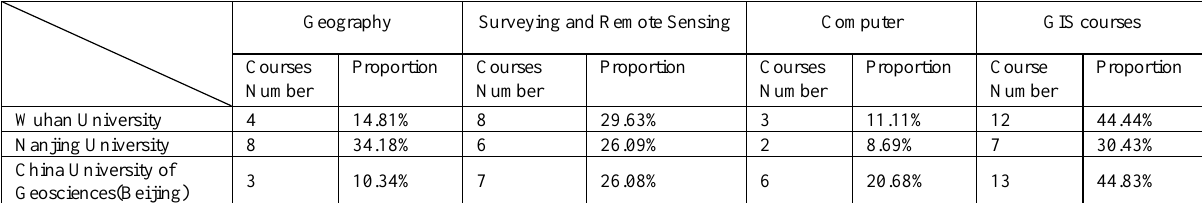
Table 3. Structure of GIS Core Course in Wuhan University, Nanjing University and China University of Geosciences (Beijing) Geography